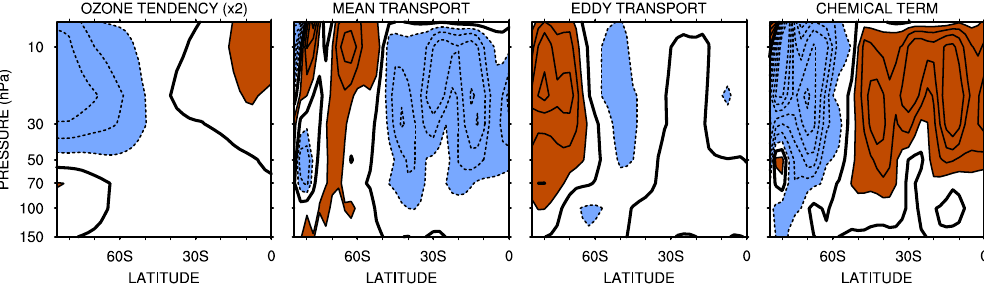
Fig. 2. Zonal-mean ozone tendency and its forcing terms averaged over DJF 1980–2001 in the SH. Dashed (solid) lines and blue (brown) colors represent negative (positive) values; the bold solid line represents the zero-line. Contour spacing is 10ppbvday − 1 . Note that the ozone tendency is weak compared to its forcing terms and is therefore multiplied by